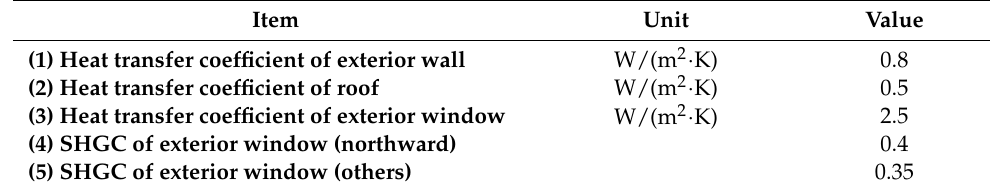
Table 3. Envelope parameters of the building models in database.